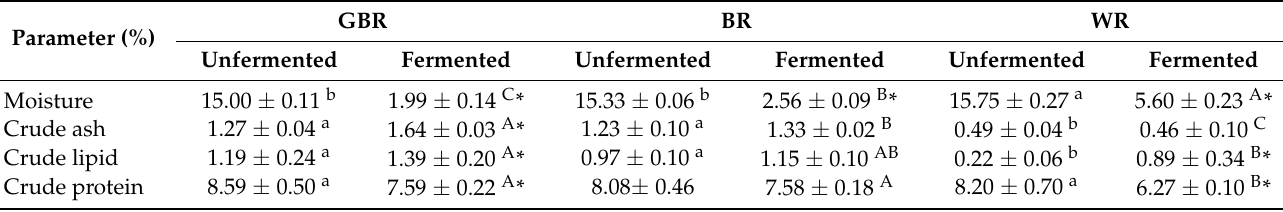
1. Data are expressed as mean ± SD ( n = 3). 2. For each of the unfermented (a,b) and fermented (A–C) groups, means within a row with the same superscript letter are not significantly different ( p < 0.05). 3. (*) indicates within each rice sample, the means of the unfermented and fermented groups are significantly different ( p <